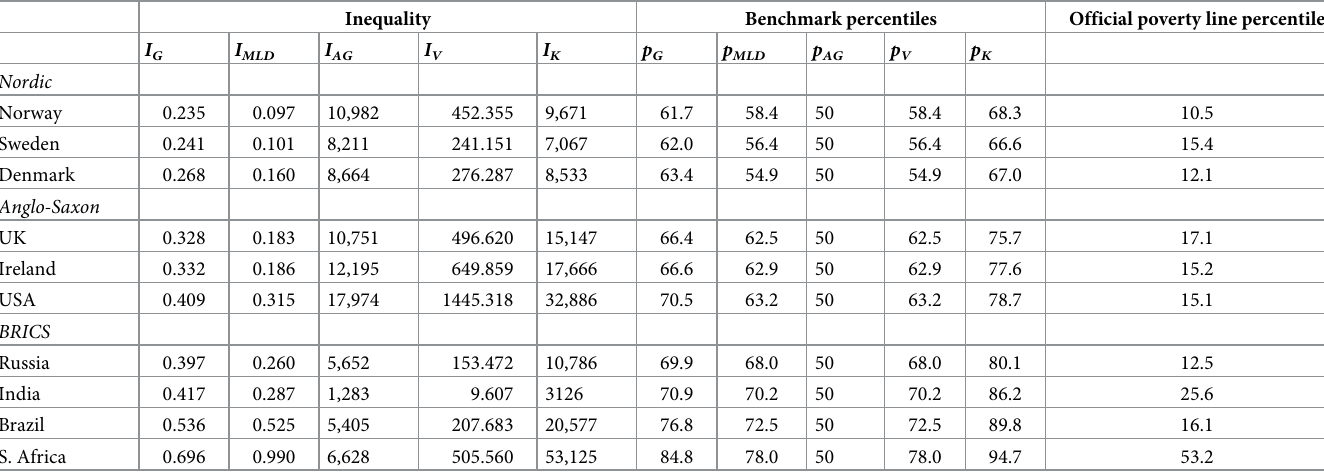
Table 2. Inequality and benchmark percentiles in 2010. Inequality Benchmark percentiles Official poverty line